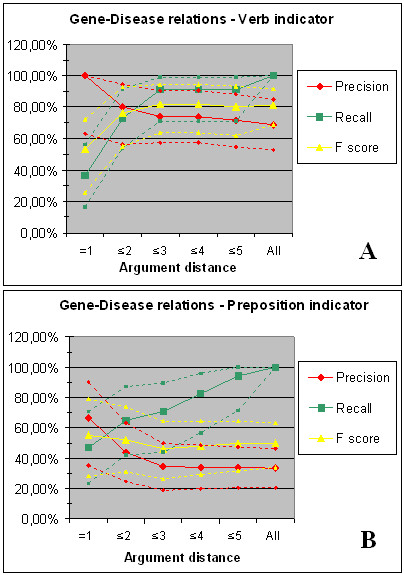
Parkinson-related etiologic relations, with official symbol for each extracted gene, filtered at increasing argument distance. Argument distance indicates the maximum distance of each argument from the indicator in the relations retained after filtering. "All" refers to no filtering. Precision (P), Recall (R), and F score (F) were calculated as follows: P = rc/(rc+ri), R = rc/(rc+dc), F = 2*P*R/(P+R) with rc the retained correct relations, ri the retained incorrect relations, and dc the discarded correct relations. Dotted lines indicate limits of 95% confidence intervals.